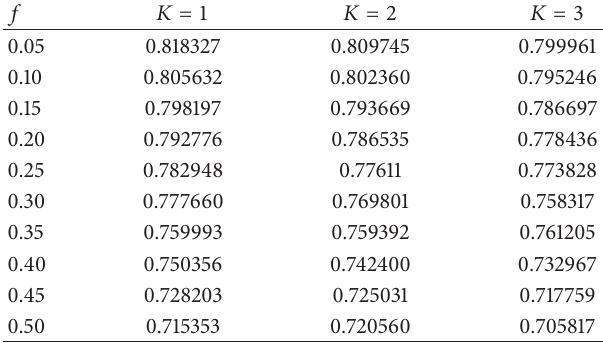
Table 2: Results for predicting missing links: AUC of 𝐾 -CNMF on Dolphins with 𝐾 = 1,2, 3 , 𝐿 = 62